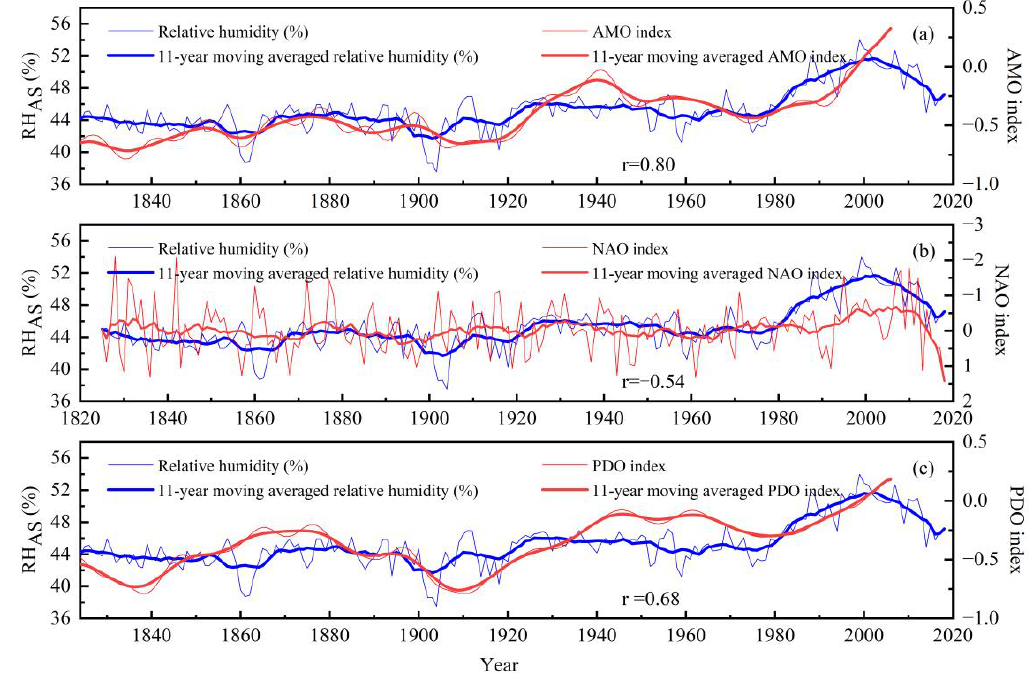
Figure 8. Comparisons between the reconstructed RH AS series on Alaer (blue line) and the AMO, NAO, and PDO series’ (red lines). ( a ) Comparisons of RH AS reconstruction and the reconstructed annual AMO [73]. ( b ) Comparisons of RH AS reconstruction and April–September averaged NAO [74]. ( c ) Comparisons of RH AS reconstruction and the reconstructed annual PDO [75].